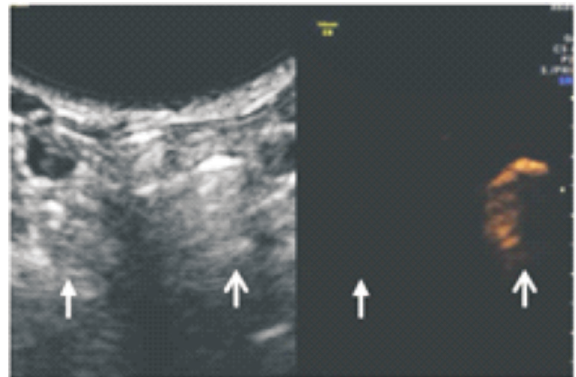
Figure 6 On CEUS-mode image (right side), there are strong echoes from the contrast agents in the area of esophagus cavity (open arrow indicating), while there are no echoes in the area corresponding to the nodule (closed arrow indicating).